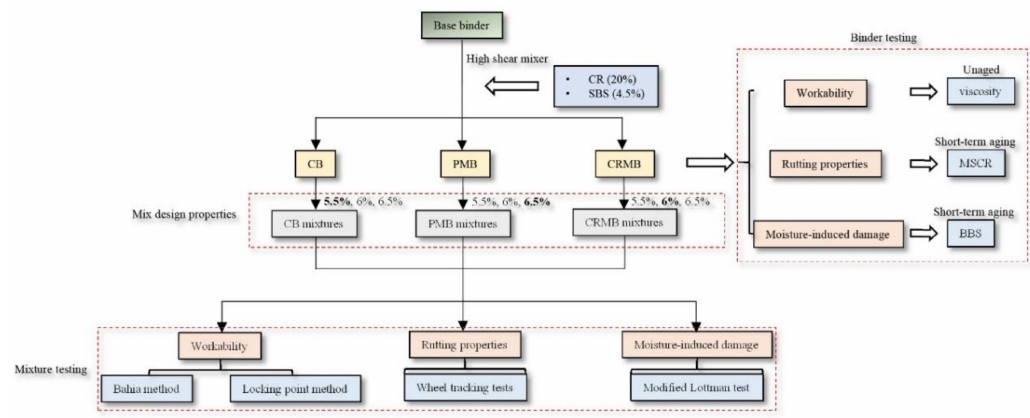
Figure 1. Methodology used in the present study.